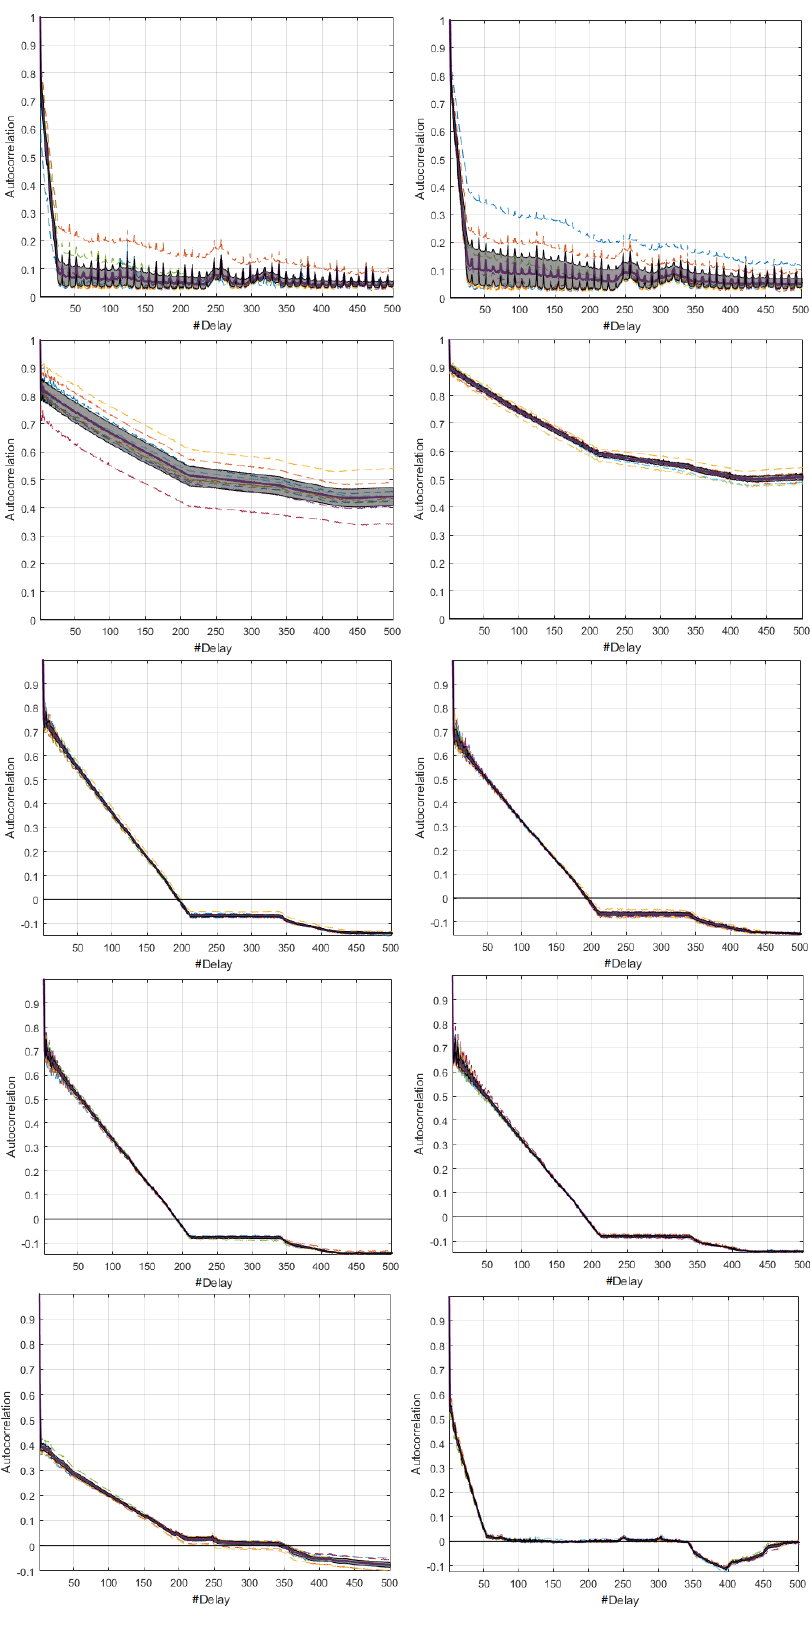
Figure 21. CI of SAF for WiFi network: ( Left ) 9600 bauds; and ( Right ) 57,600 bauds. From top to bottom: Coordinator, and Nodes